Question: Condense the content of this figure into a single sentence.
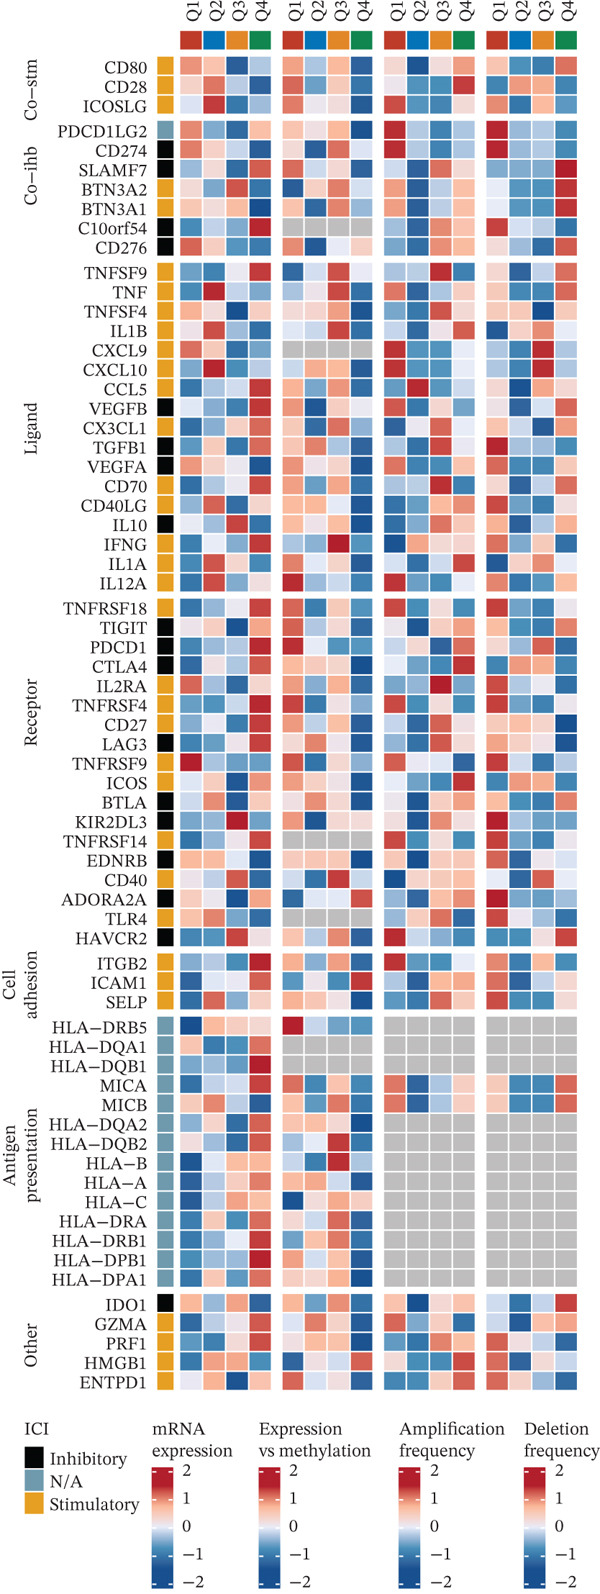
Answer: Multimodal immunomodulator dysregulation in RBM27‐high HCC. (a) Multimodal immunomodulator dysregulation in RBM27‐high HCC. (b) Suppressive impact of RBM27 on the cancer‐immunity cycle. (c) Immunosuppressive phenotype of RBM27‐high tumors. (d) Altered immune subtype distribution in RBM27‐high hepatocellular carcinoma. (C2 is IFN‐ γ ‐dominant, C3 is inflammatory, C4 is lymphocyte‐depleted [ 20 ]).